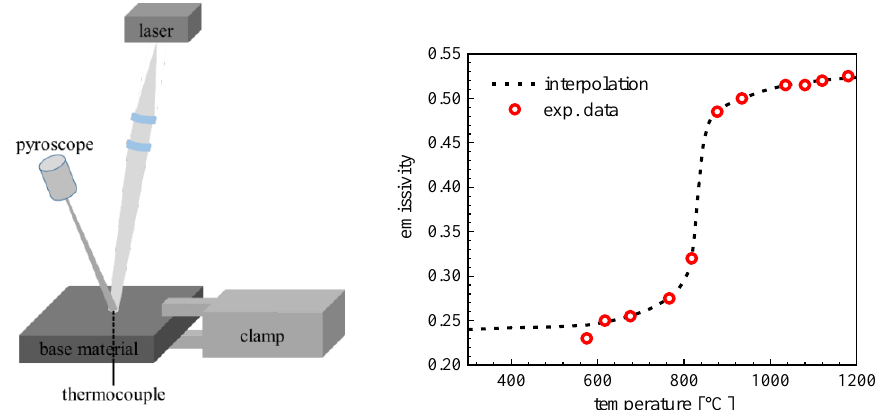
Figure 4. Temperature-dependent emissivity: measurement setup ( left ) and emissivity curve of IN 738 LC ( right ).